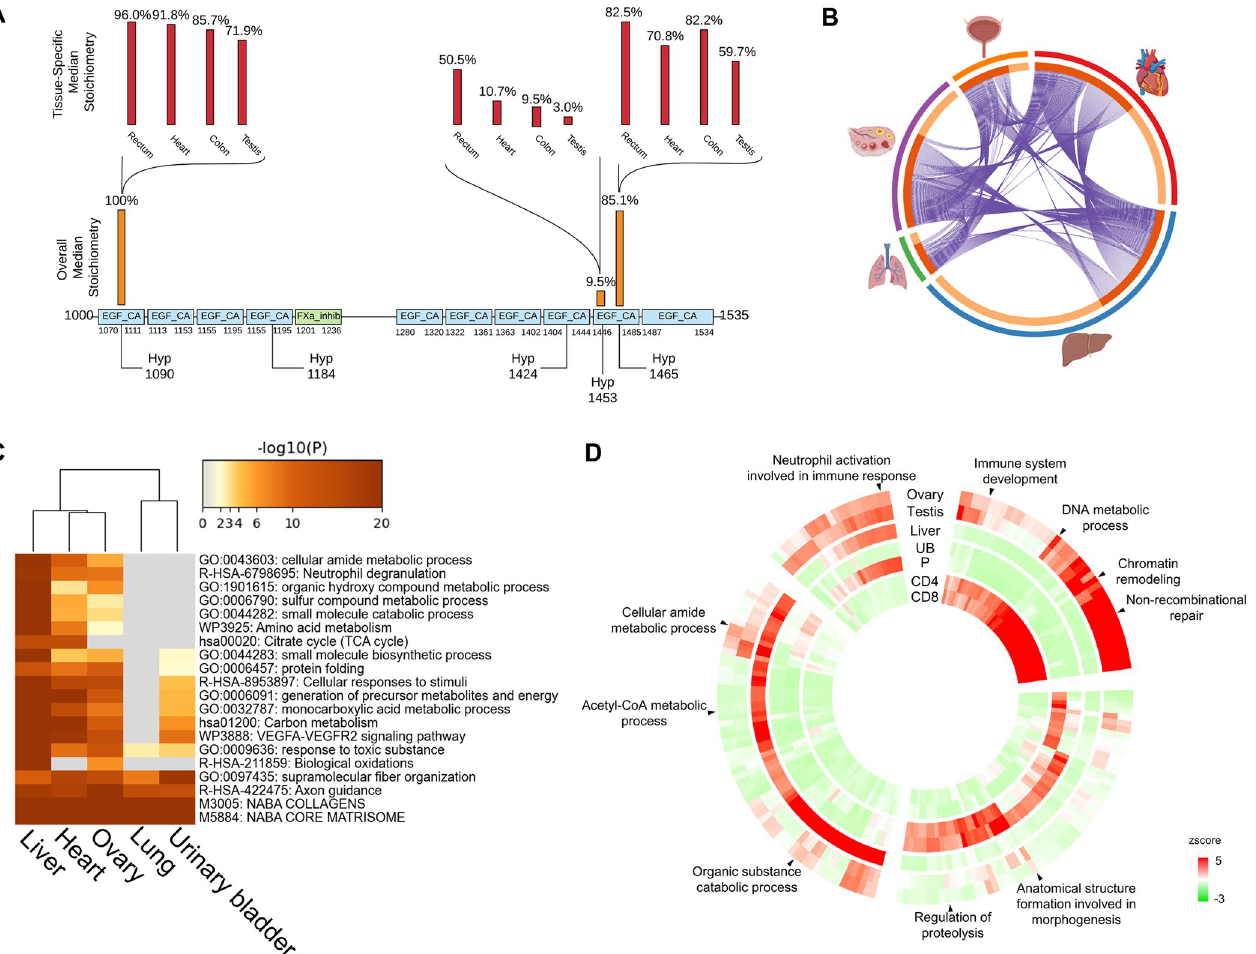
Fig 6. Hyp proteome distributions in different tissues. (A) An example showing varying stoichiometries of Hyp sites across different types of tissue for FBN1 with protein domains labeled in colored boxes. (B) Correlation plot of Hyp proteins in 5 different tissues: heart, liver, lung, ovary, and urinary bladder with the size of arc shows relative number and the purple curved lines showing overlap proteins (C) Heat map of the top 20 enriched functional annotations of the Hyp proteins in 5 tissues. (D) GO biological process enrichment heat map of the Hyp proteins across 7 tissues. Refer to Sheet A in S2 Table, Sheet D-E in S8 Table for the underlying data of Fig 6B–6D. CD4, CD4 T cells; CD8, CD8 T cells; FBN1, Fibrillin-1; Hyp, proline hydroxylation; P, prostate; UB, urinary